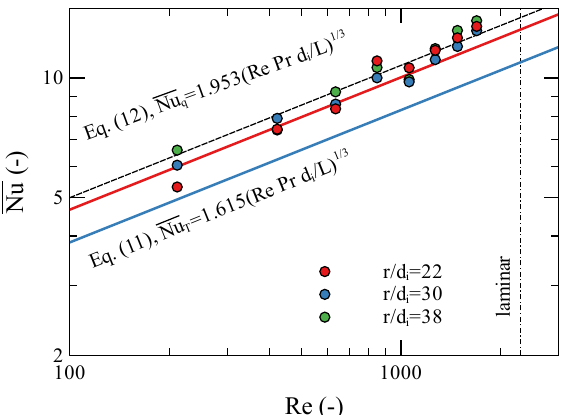
Figure 15. Average values of Nusselt number versus Reynolds number for 180 degree bent pipes. The dashed black line represents the regression of all measured data.